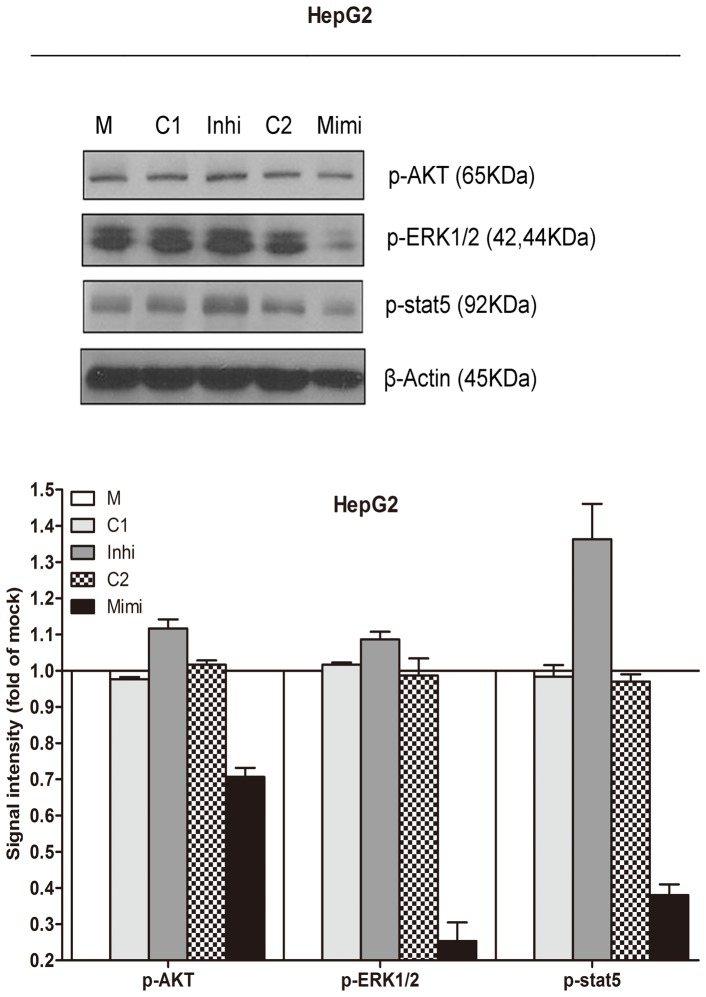
Effect of miR-34a on downstream pathway signals in HCC cells.Western blot and signal intensity of the bands. Antibodies include: phospho-AKT (p-AKT), p-ERK1/2, p-stat5 and β-actin. M: mock control; C1: Negative control for miRNA inhibitor; Inhi: miR-34a inhibitor; C2: Negative control for miRNA mimic; Mimi: miR-34a mimic.